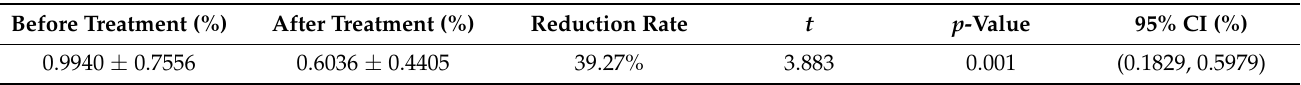
Table 2. Comparison of the average movement value before and after treatment of 25 patients. Before Treatment (%)